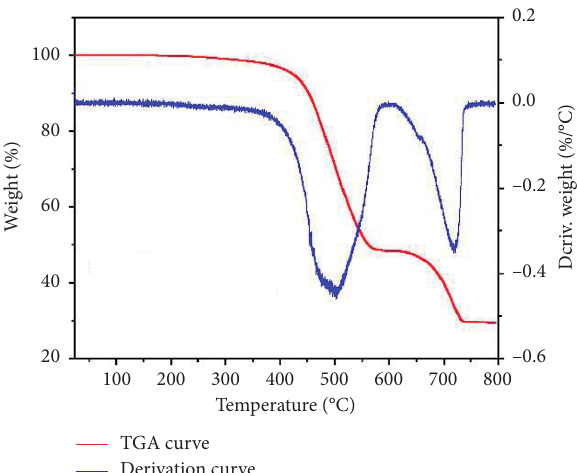
Figure 11: TGA thermo gram results of sealing film with a temperature increase rate of 10min/ ° C in N